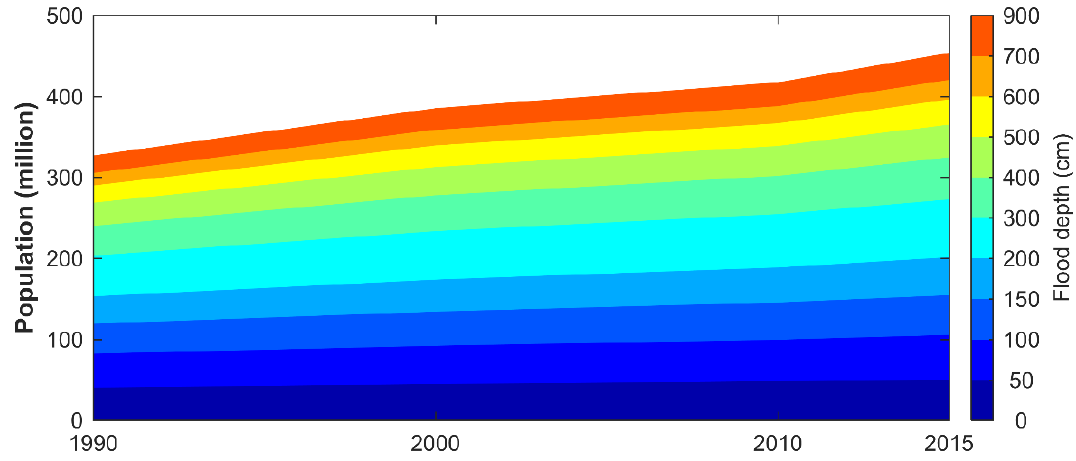
Figure 3. Population in Chinese floodplain for different flood depths.